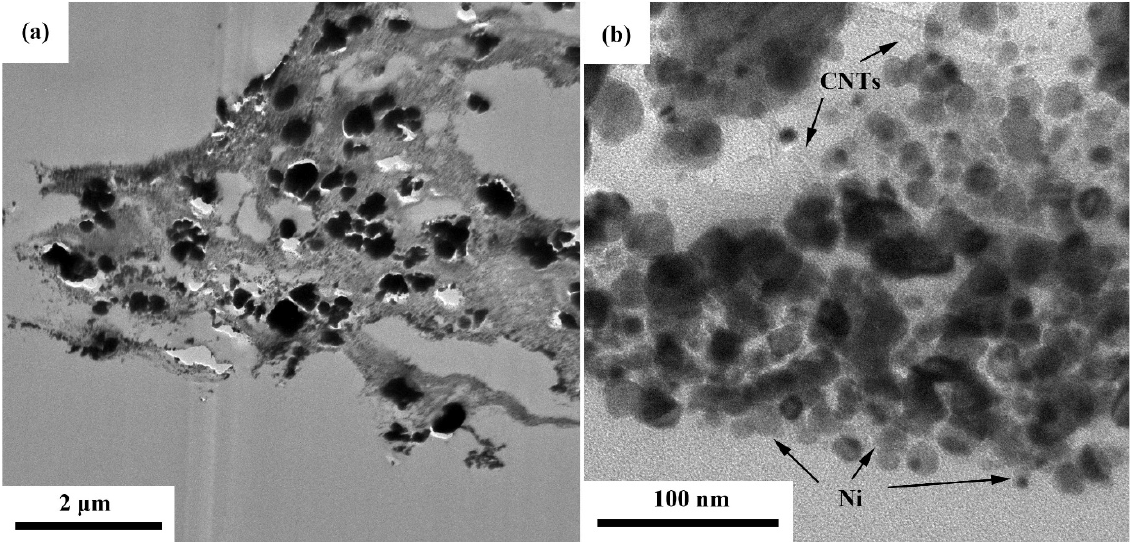
Figure 7. TEM image of NiGNT–epoxy composites under low ( a ) and high ( b ) magnification.